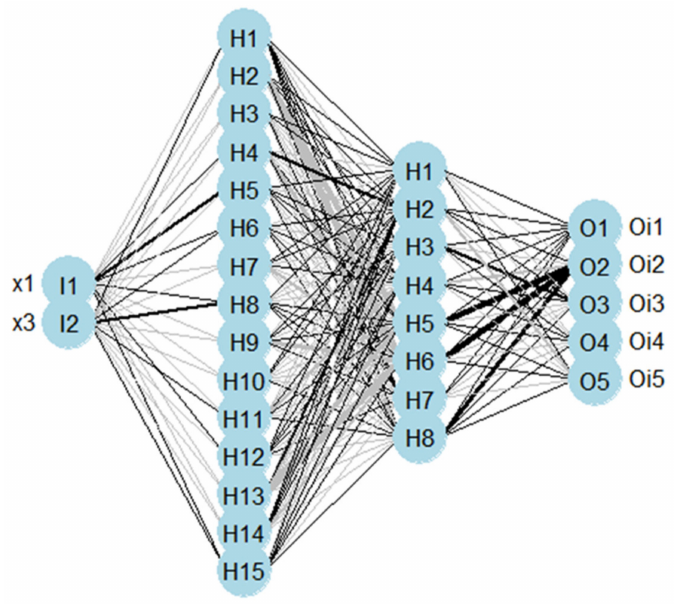
Figure 5. The architecture of the proposed TLFN (15,8) model.